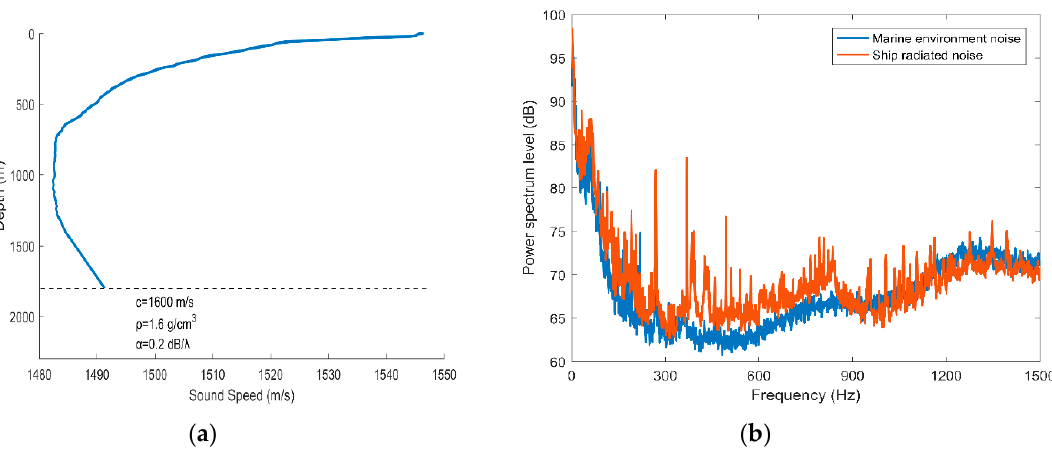
Figure 13. ( a ) Measured sound speed profile; ( b ) spectrum level of the radiated noise from the ship.